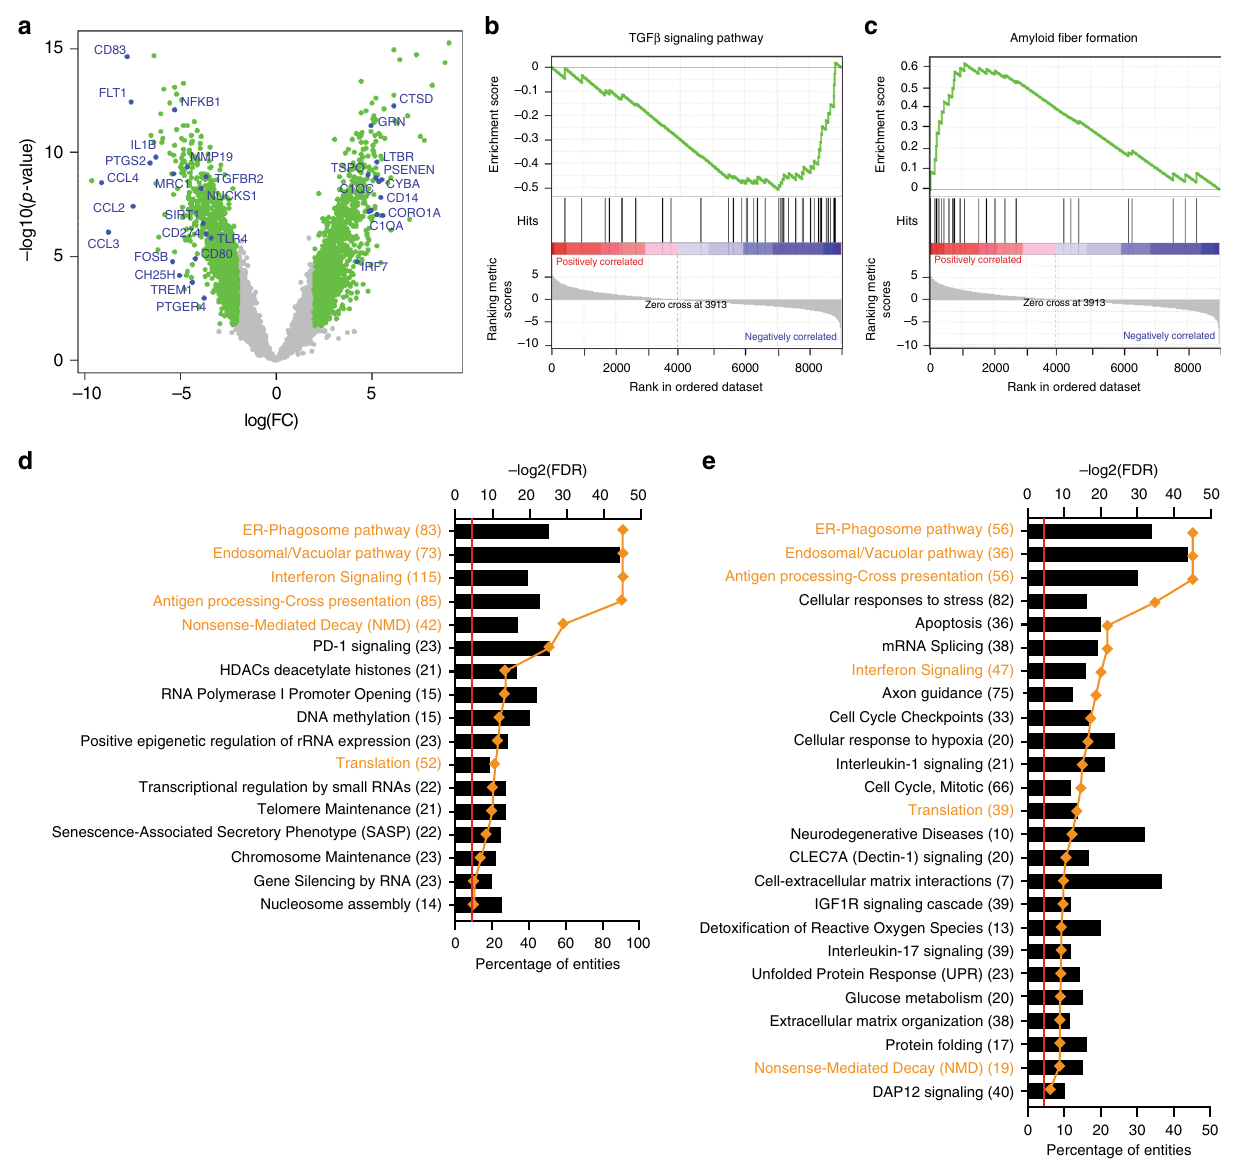
Fig. 2 The phenotype of aged human microglia. Functional annotation reveals that human microglia aging manifests itself as loss of function as well as gain of function changes in phenotype. a Volcano plot depicting the results of differential gene expression analysis between the Zhang et al. (middle aged microglia; N = 3) and our dataset (aged microglia; N = 10). One thousand sixty genes were found to be upregulated while 1174 genes were downregulated with aging. b , c GSEA enrichment plots of representative gene sets that were signi fi cantly enriched in either downregulated ( b ) or upregulated ( c ) genes. The TGF β signaling pathway gene set was enriched in downregulated genes (loss of function with aging, ( b )) while the Amyloid fi ber formation pathway was enriched in upregulated genes (gain of function with aging, ( c )). d Pathway analysis of the genes that were signi fi cantly upregulated with aging in microglia in the two RNA-Seq datasets. e Pathway analysis of the proteins detected with a shotgun proteomic approach in aged human microglia. Please note the signi fi cant overlap between the functional phenotypes revealed by the two approaches (overlapping REACTOME entities highlighted in orange). Legends in d and e : orange diamonds ( – log2(FDR)), columns (Percentage of entities). GSEA gene set enrichment analysis, FDR